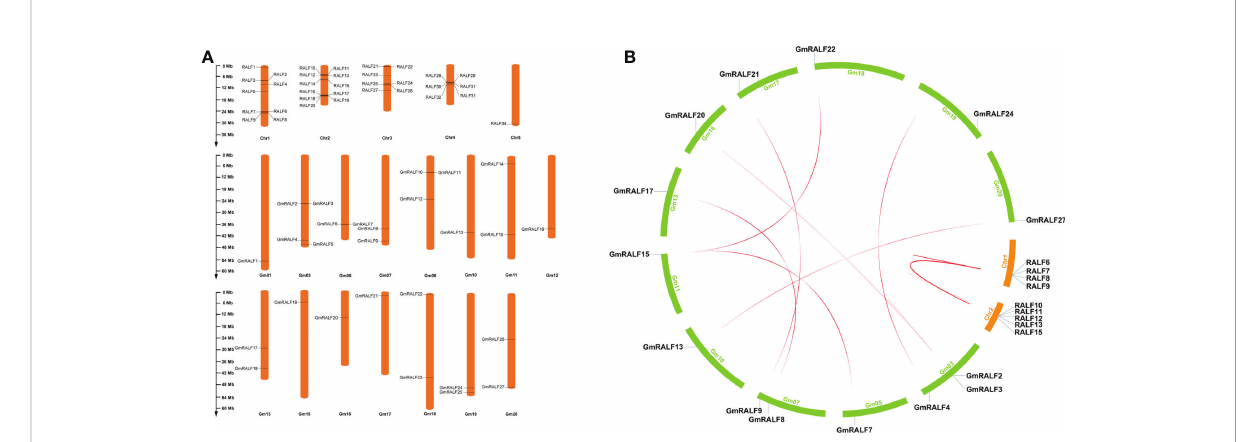
FIGURE 4 Gene location and synteny. (A) The chromosomal distributions of RALFs in soybean and Arabidopsis genome. The GmRALFs were not evenly distributed in 15 soybean chromosomes. The chromosome names were set at the top of the chromosomes. The length of each chromosome can be estimated by using the scale on the left hand. (B) Synteny analysis of RALF genes between soybean and Arabidopsis .